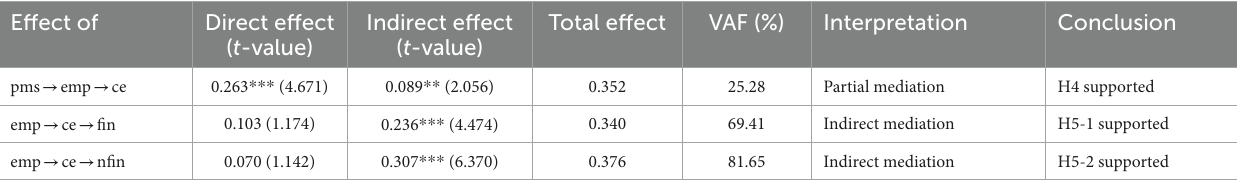
TABLE 6 Test of mediation by bootstrapping